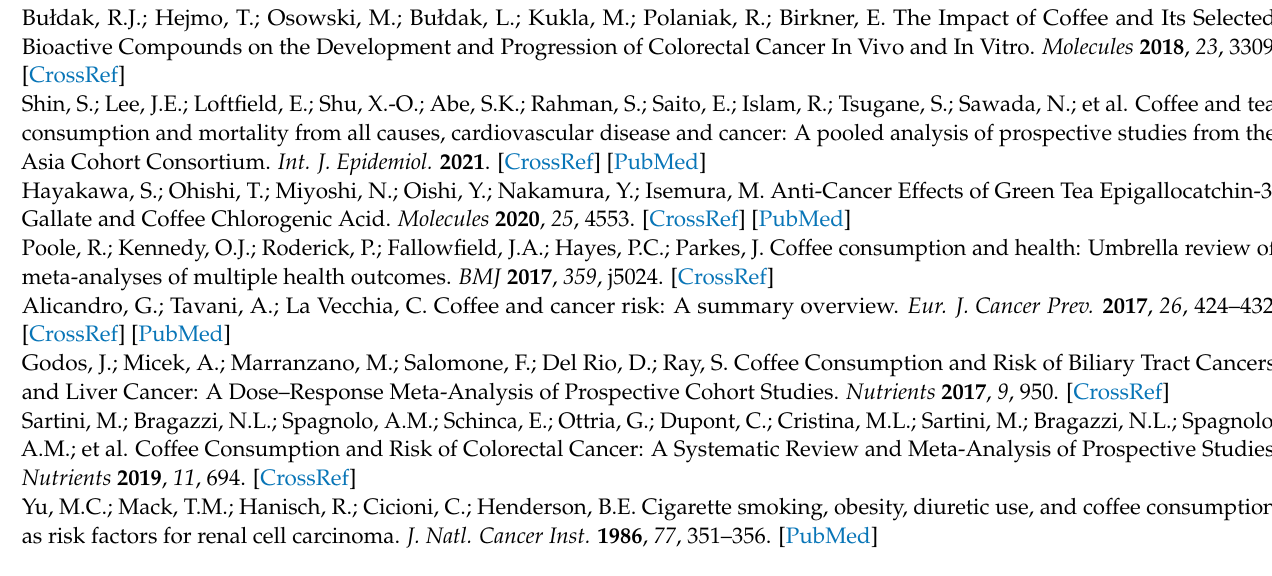
for prostate cancer histories, Table S10: Crude and adjusted odd ratios (95% confidence interval) of coffee drinking habit for bladder cancer histories, Table S11: Crude and adjusted odd ratios (95% confidence interval) of physical exercise for gastric cancer histories, Table S12: Crude and adjusted odd ratios (95% confidence interval) of physical exercise for hepatic cancer histories, Table S13 Crude and adjusted odd ratios (95% confidence interval) of physical exercise for colon cancer histories, Table S14: Crude and adjusted odd ratios (95% confidence interval) of physical exercise for breast cancer histories, Table S15: Crude and adjusted odd ratios (95% confidence interval) of physical exercise for uterine cervix cancer histories, Table S16: Crude and adjusted odd ratios (95% confidence interval) of physical exercise for lung cancer histories, Table S17: Crude and adjusted odd ratios (95% confidence interval) of physical exercise for thyroid cancer histories, Table S18: Crude and adjusted odd ratios (95% confidence interval) of physical exercise for prostate cancer histories, Table S19: Crude and adjusted odd ratios (95% confidence interval) of physical exercise for bladder cancer histories, Table S20: Crude and adjusted odd ratios (95% confidence interval) of physical exercise for thyroid cancer histories, Table S21: The interaction between coffee consumption, and physical exercise for various cancer histories, Table S22: The association between physical exercise and thyroid cancer in the subgroup analyses by coffee consumption, Table S23: The association between coffee consumption and thyroid cancer in the subgroup analyses by physical